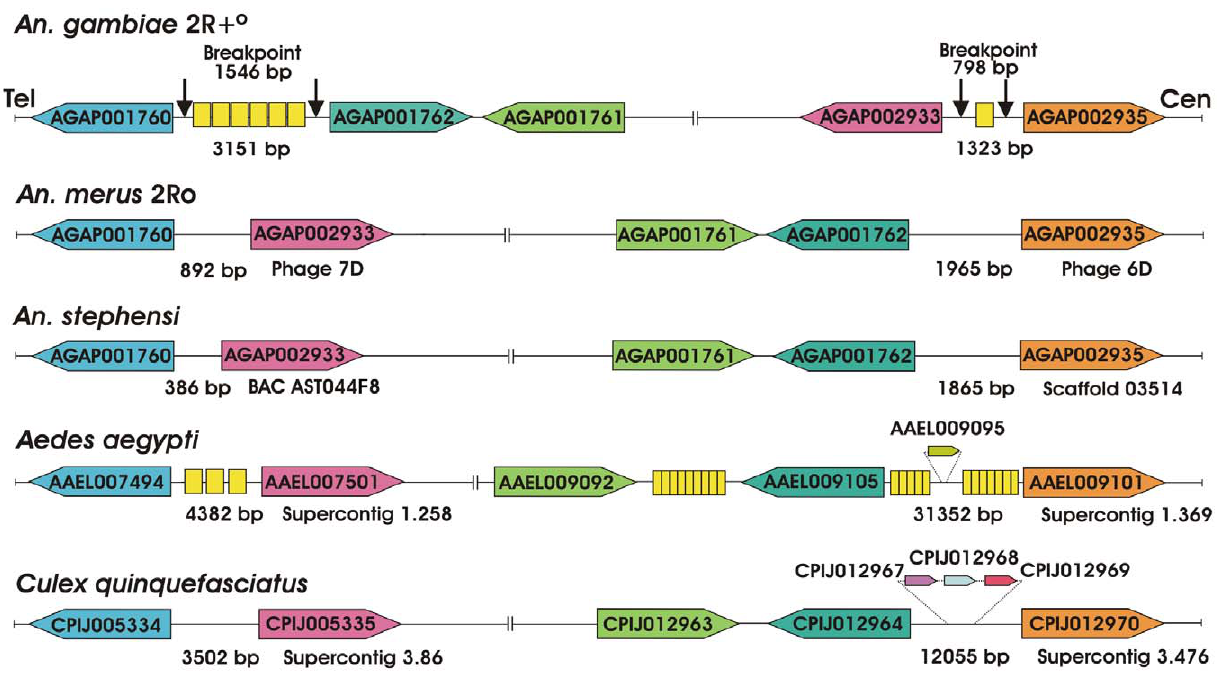
Figure 5. Gene orders in assembled sequences of the 2R + o and 2Ro breakpoints. Genes of An. gambiae and An. merus as well as three outgroup species An. stephensi , Ae. aegypti , and C. quinquefasciatus are shown. Breakpoint regions in An. gambiae are represented by vertical black arrows with their sizes in base pairs. Homologous genes are show in their 5 9 -3 9 orientation with boxes of similar colors. Distances between genes are shown in base pairs and are not depicted proportionally. The correct orientation of genes with respect to the centromere (Cen) and telomere (Tel) is shown only for An. gambiae . Additional genes at the breakpoints of Ae. aegypti and C. quinquefasciatus are shown in a smaller scale. Yellow boxes show assemblies of degenerate TEs. In the An. gambiae breakpoints, TEs are shown in the following order from left to right: AgaP15, DNA-4_AG,